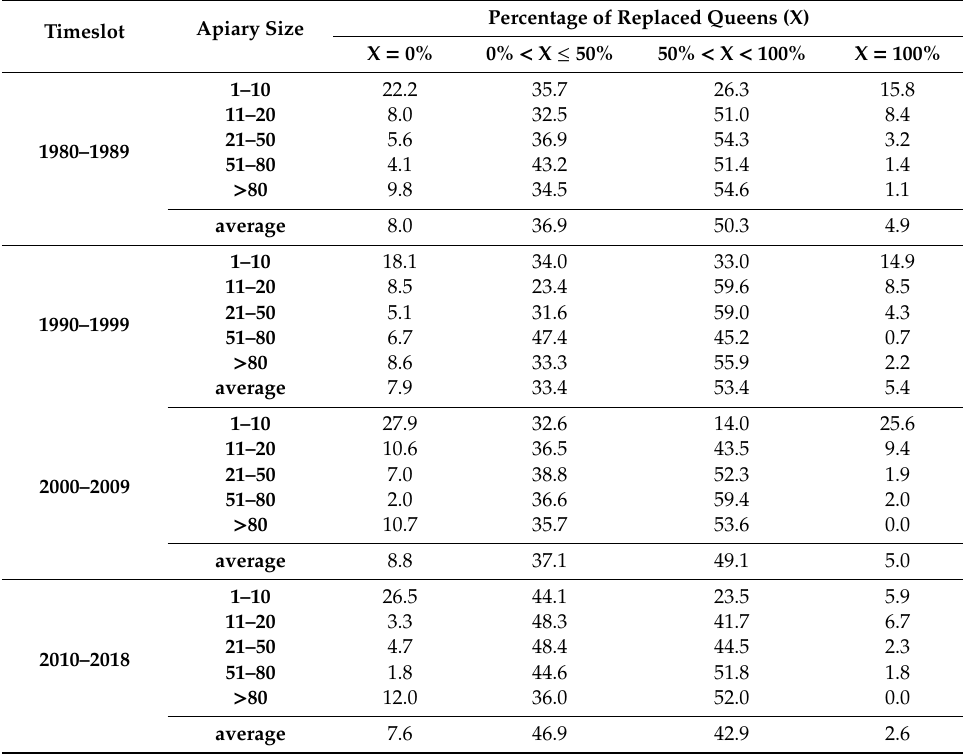
Table A2. Percentage of replaced queens by beekeepers, analyzed by decade timeslot and apiary size. Timeslot